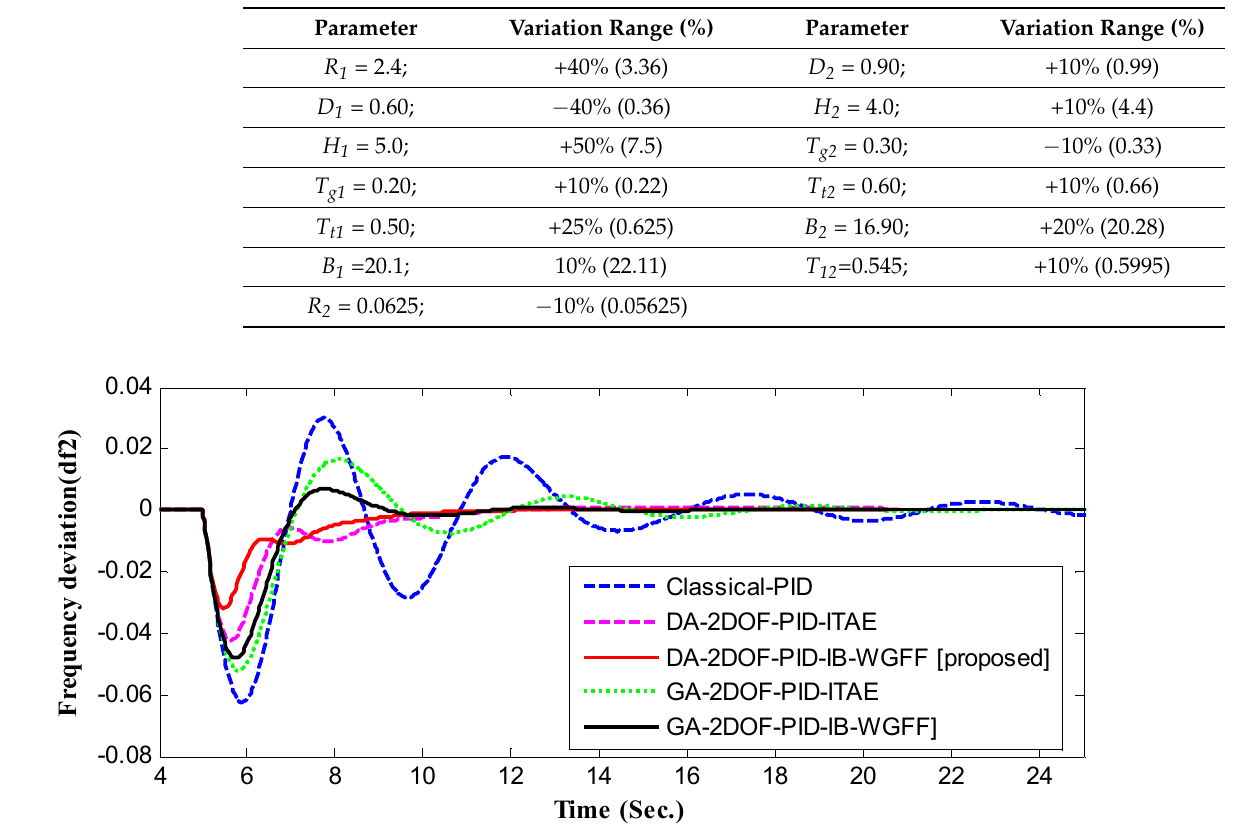
Figure 30. Frequency deviation ( ∆ f ) of area 2 under parameter perturbations.